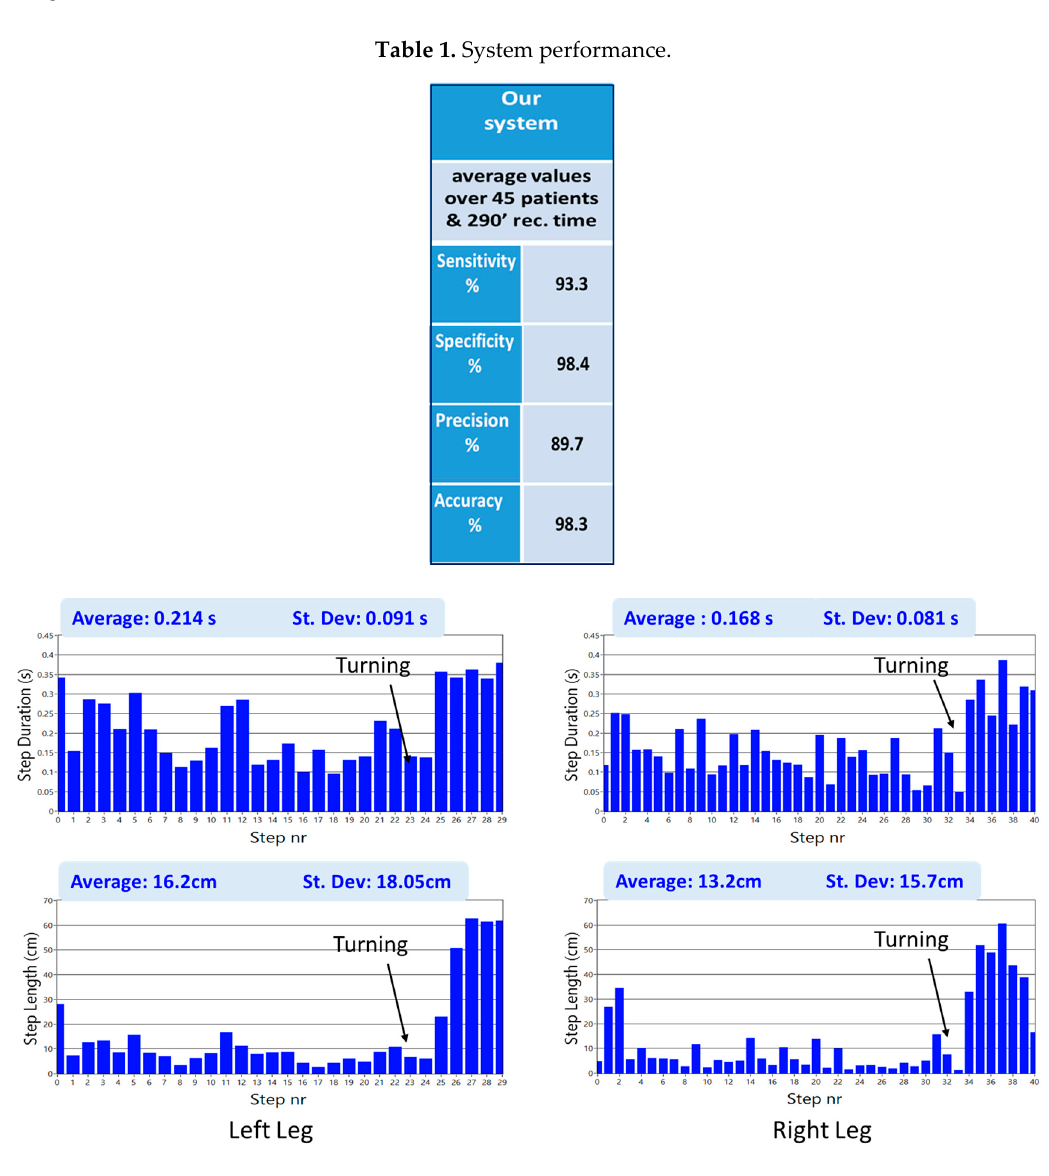
Figure 4. Absolute and average values, standard deviation of step duration and length of the two legs.